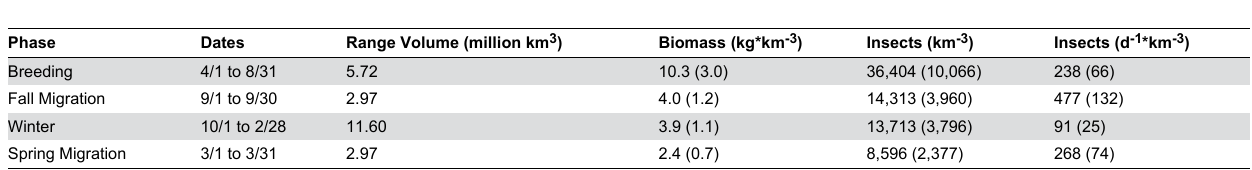
Table 4. Model based estimates of the biomass and number of insects consumed by Purple Martins during the breeding, migratory, and winter phases of its annual